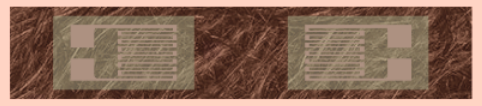
Figure 3. Illustration of the process steps using inkjet printing to integrate the strain sensor into the carbon fibre composite.